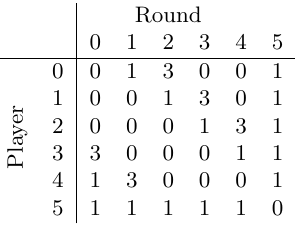
Table 3: The carry-over effects matrix for the round-robin tournament in Table